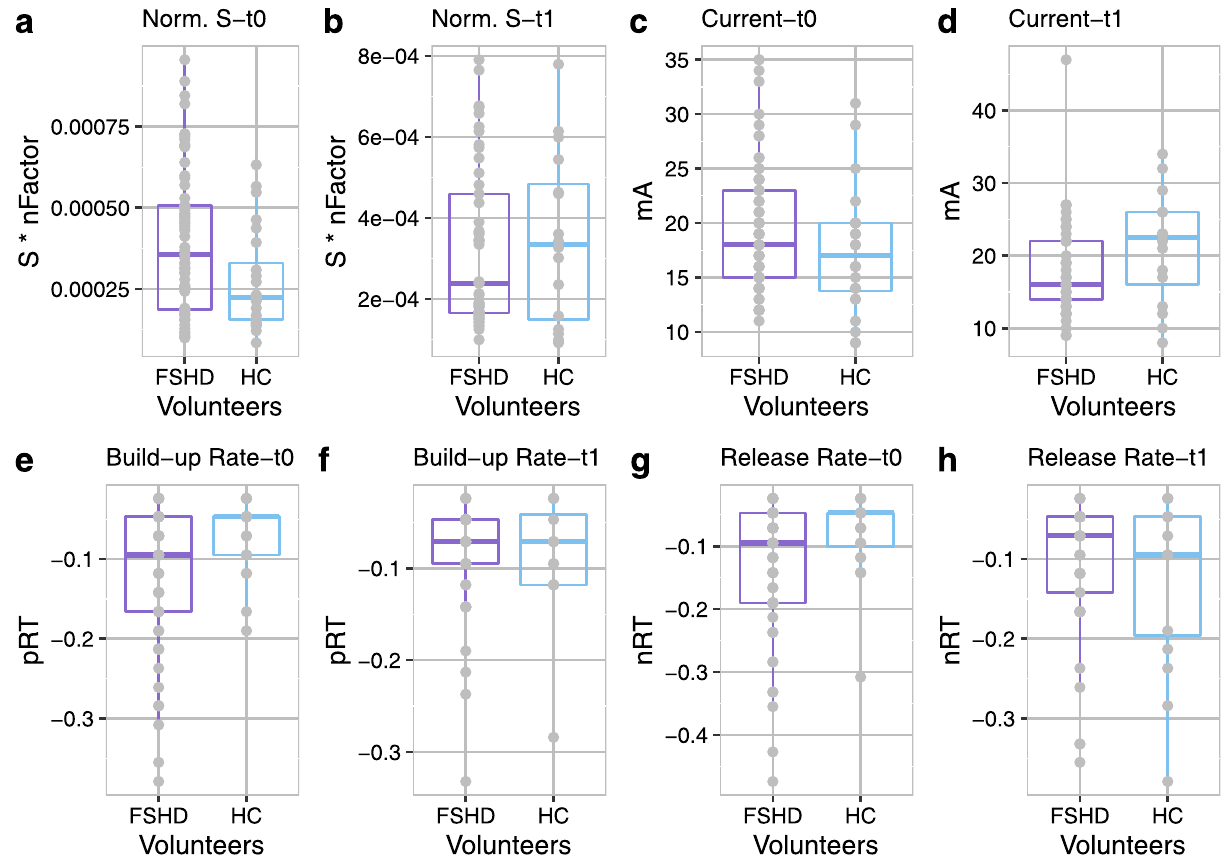
Figure 2. (a ) Normalized strain (S) at baseline (t0) for FSHD patients and healthy controls (HCs) (FSHD/ HCs (1st quantile-Q1) = 1.9e−4/1.6e−4, (median-M) = 3.6e−4/2.2e−4, (3rd quantile-Q3) = 5.1e−4/3.3e−4), ( b ) normalized strain (S) at time point t1 for FSHD patients and HCs ((Q1, M, Q3) for FSHD/HC (1.7e−4/1.5e−4, 2.4e−4/3.3e−4, 4.6e−4/4.8e−4)), ( c ) current applied in mA for t0 (FHSD/HC (Q1, M, Q3) = (15/13.8, 18/17, 23/20) mA, ( d ) current applied in mA for t1 FSHD/HC ((Q1, M, Q3) = (14/16, 16/22.5, 22/26)), ( e ) build-up rates (pRT) at t0: FSHD/HC (Q1, M, Q3) = (−0.17/−0.1, −0.1/−0.05, −0.05/−0.05)), and ( f ) at t1 (−0.1/−0.12, −0.07/−0.07, −0.05/−0.04), ( g ) release-rates (nRT) at t0: nRT-FSHD/HC (−0.19/−0.1, −0.1/−0.05, −0.05/−0.05) and t1 ( h ): nRT-FSHD/HC −0.14/−0.2, −0.07/−0.1, −0.05/−0.05). Here, data is reported as a total with no differentiation. nFactor is the normalization factor for